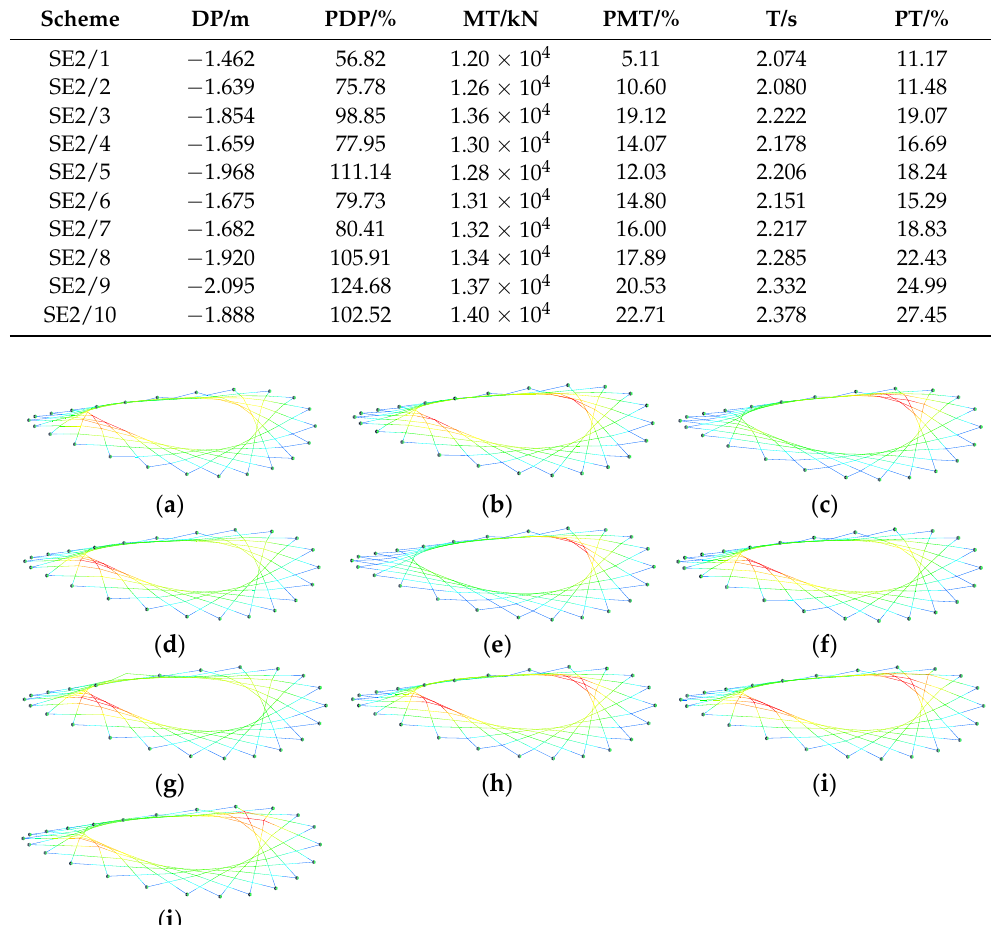
Figure 9. Vibration modes of schemes deleting two virtual rings. ( a ) SE2/1; ( b ) SE2/2; ( c ) SE2/3; ( d ) SE2/4; ( e ) SE2/5; ( f ) SE2/6; ( g ) SE2/7; ( h ) SE2/8; ( i ) SE2/9; ( j ) SE2/10.